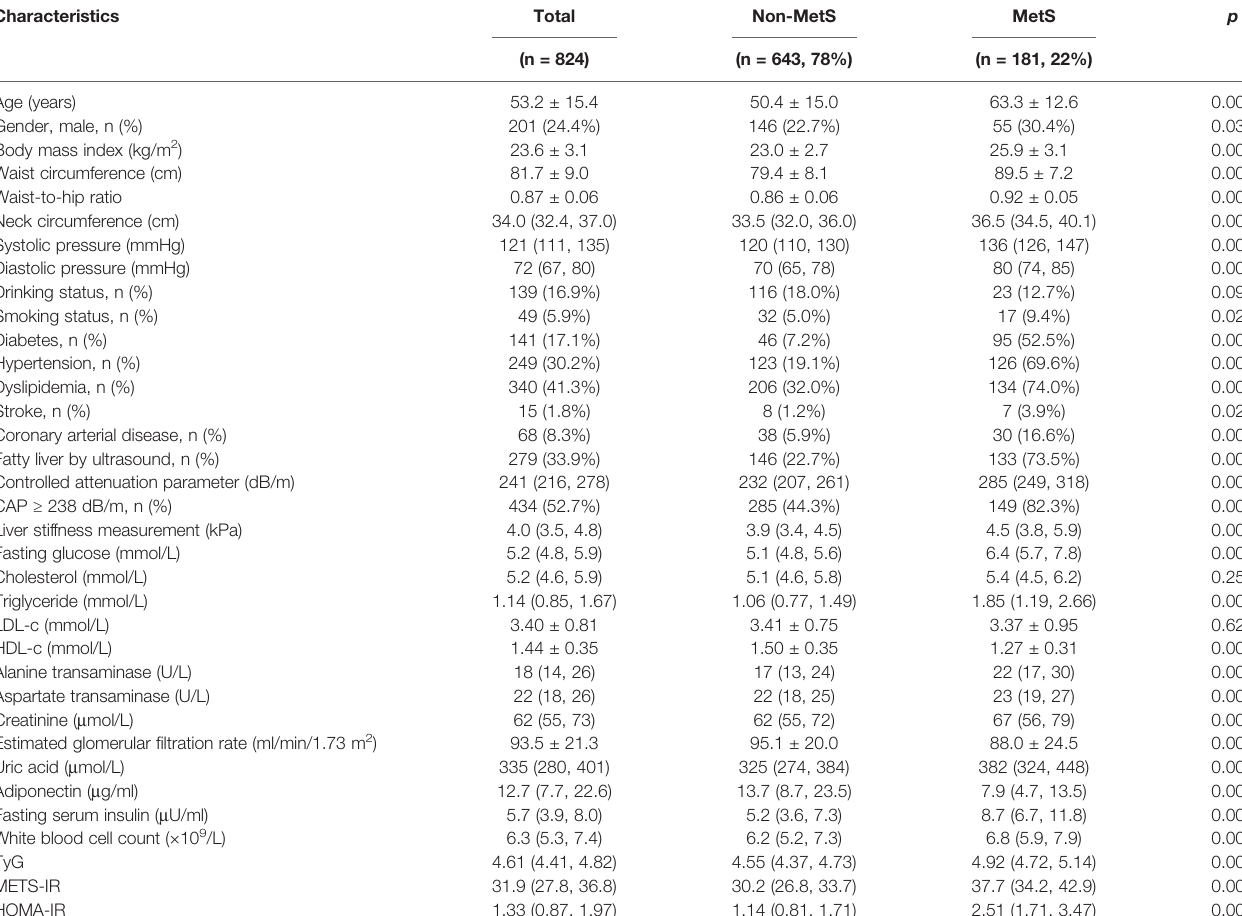
TABLE 1 | Clinical characteristics of the study population and comparisons between subjects with and without MetS.